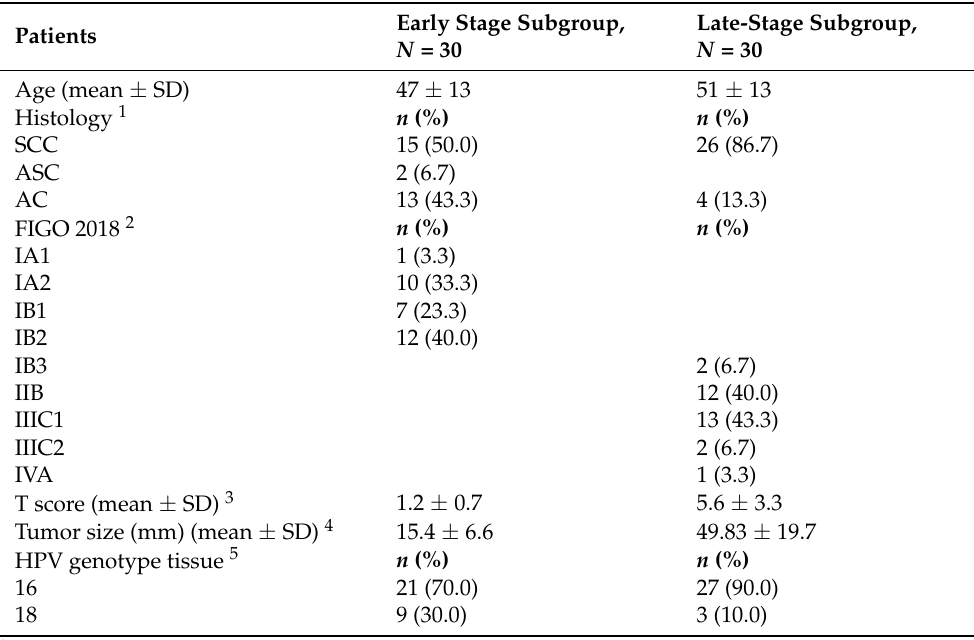
Table 1. Patient and tumor characteristics for the two subgroups ( N =